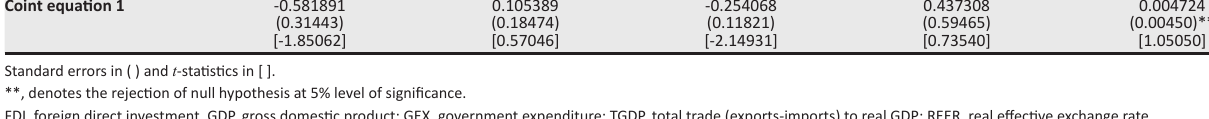
TABLE 5: Error correction estimates from vector error correction model. Error Correction